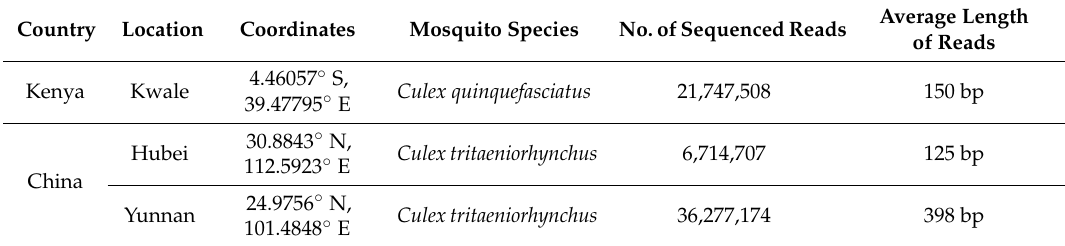
Table 1. Summary of the sampling sites, mosquito species and sequenced data.